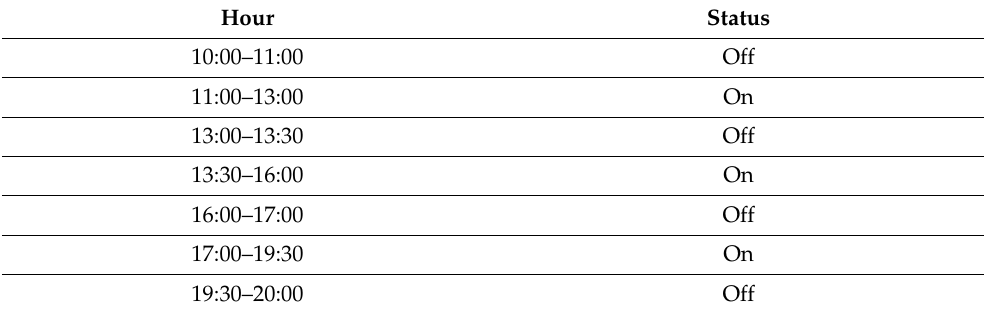
Table 4. Plan of using the device connected to Plug 1—managed by the